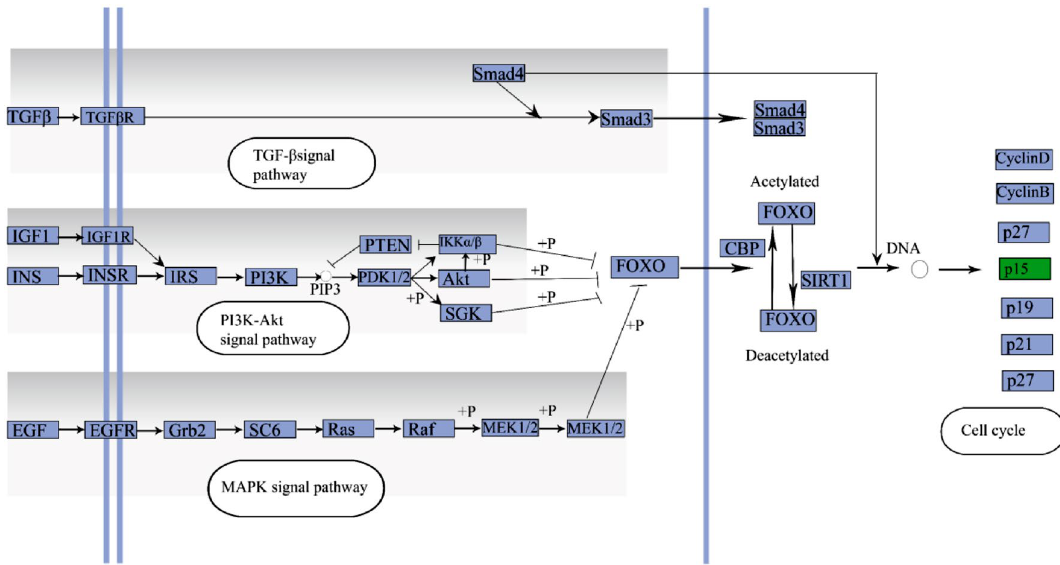
Figure 6. Cell cycle at high altitudes (The purple boxes represent enzymes or genes, green box represent down- regulated). The pathway was visualized by the Adobe Illustrator software (https:// www. adobe. com/ cn/ produ cts/ illus trator.